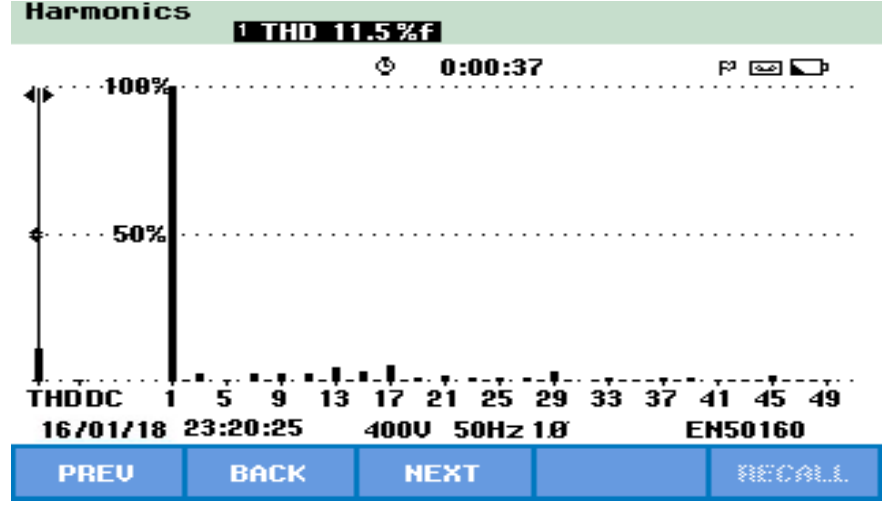
Figure 33. THD analysis of the TLBDCLCHB inverter output using the SPWCAD technique.